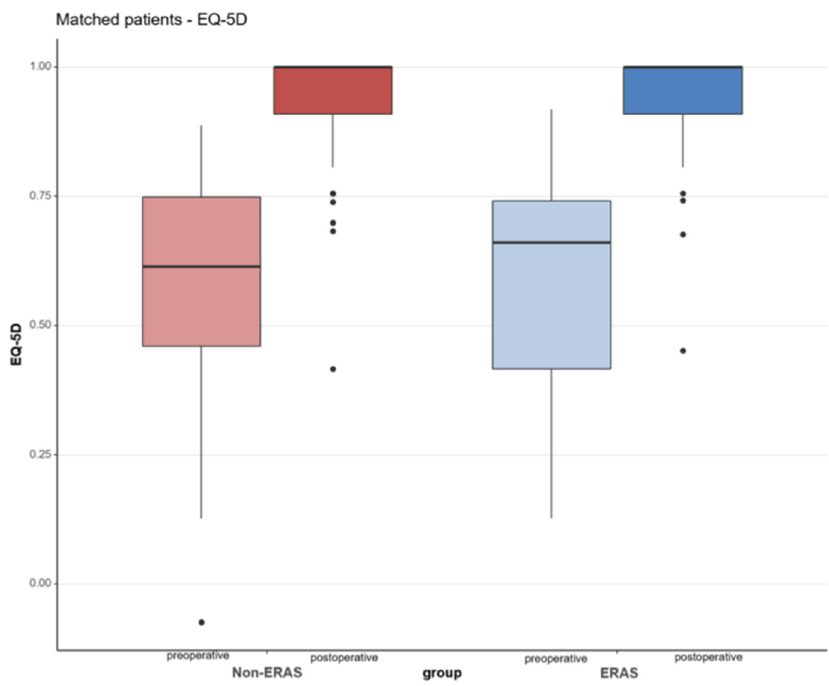
Figure 3. Euroqol (EQ-5D) with its five dimensions of mobility, self-care, usual activities, pain/discomfort and anxiety depression, at the time preoperatively (pre) and 12 months postoperatively (post). Shown in the red color: non-ERAS group; blue color: ERAS group.